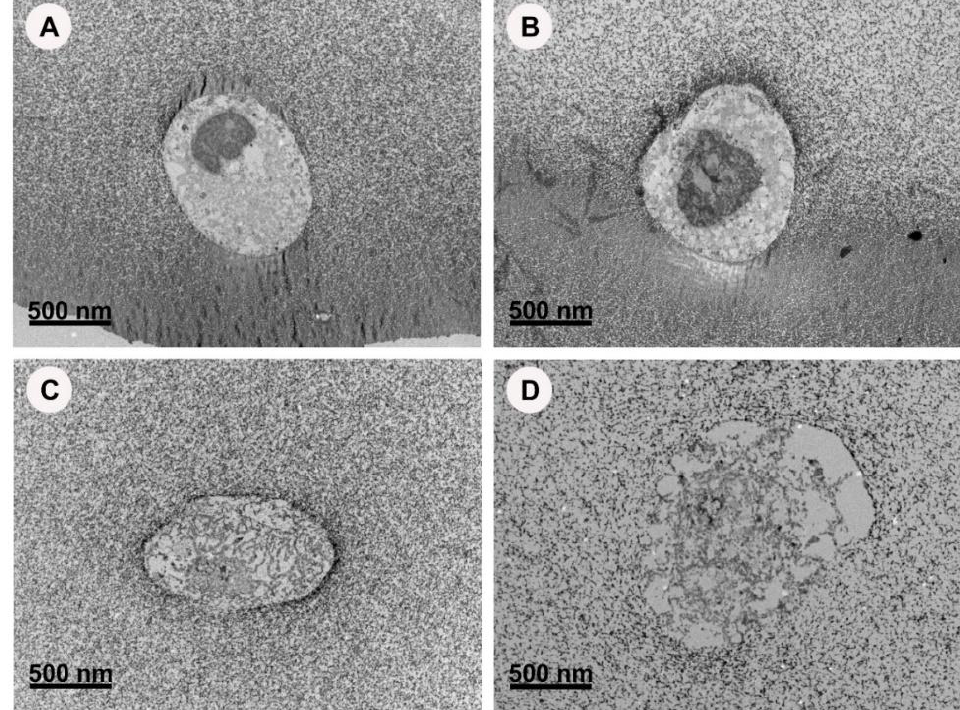
Figure 7. TEM images showing a human gingival fibroblasts cell encapsulated in GelMA containing different concentration of AgNPs. ( A ) Control, 0 µg/mL; ( B ) 0.1 µg/mL; ( C ) 100 µg/mL; ( D ) 200 µg/mL.